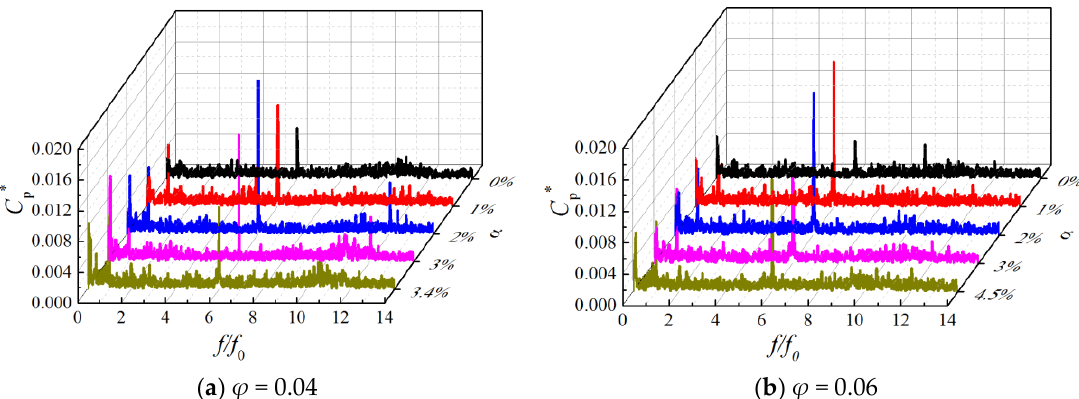
Figure 5. Frequency domain diagram of outlet pressure fluctuations for several inlet air void fractions and two different flow coefficients.